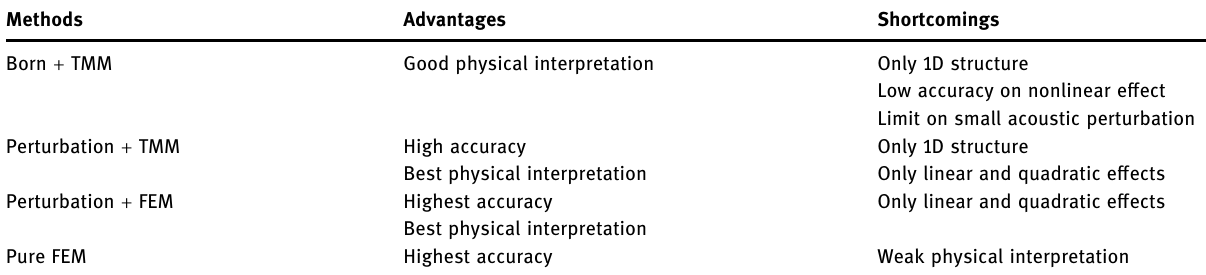
Table 3: Advantages and shortcomings of these four methods for evaluating AO coupling Methods